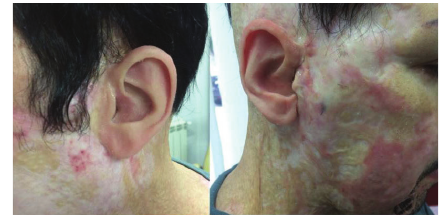
Figure 3: Final result: the patient after epithesis